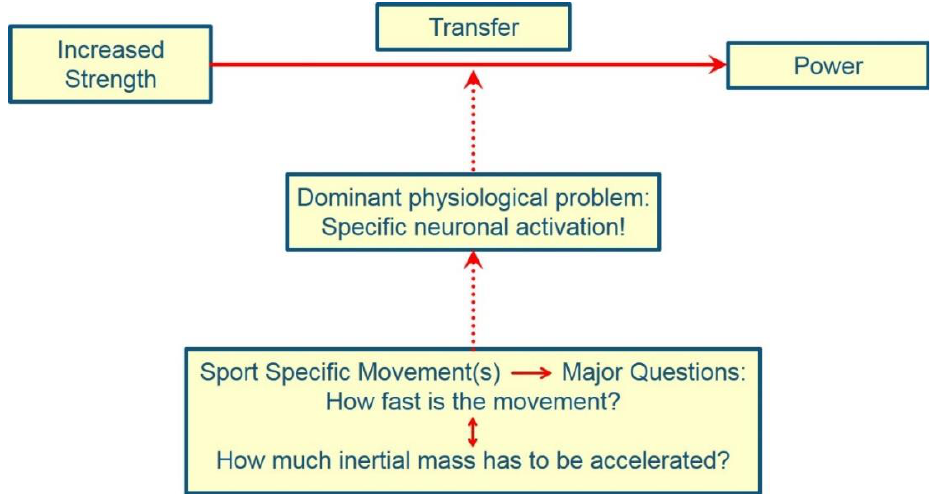
Figure 2. Realization of maximum strength in a fast movement.